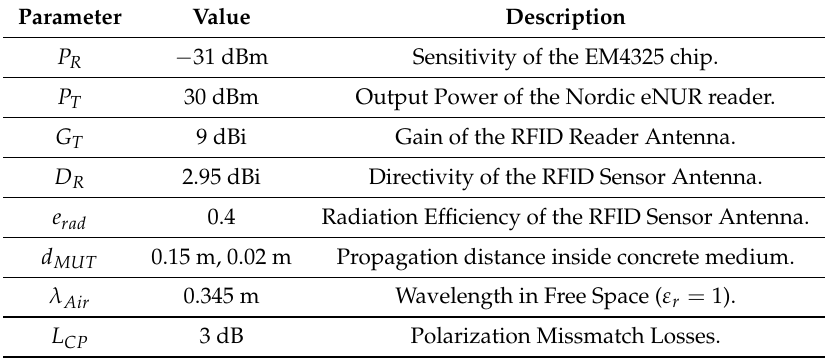
Table 2. RFID communication link parameters.